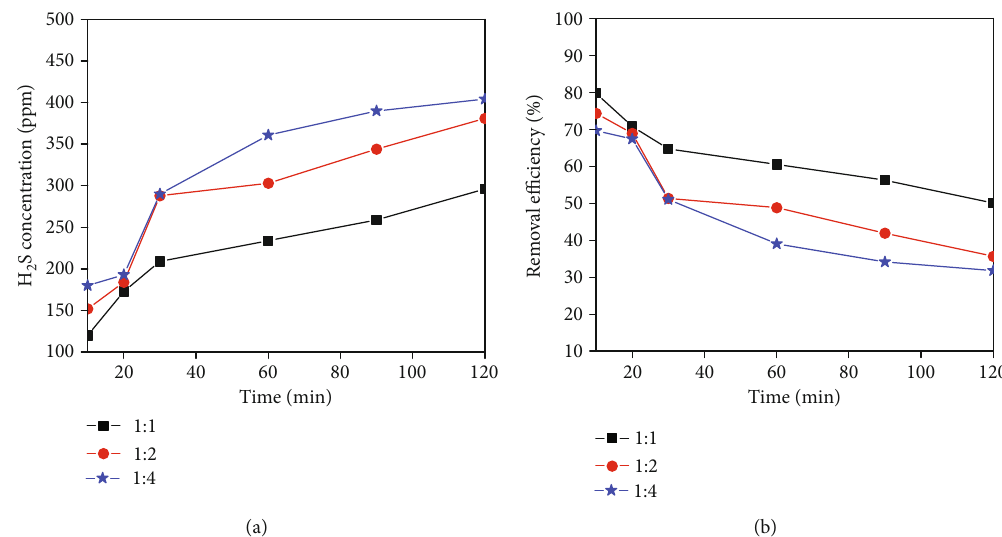
Figure 6: E ff ect of the KOH: C ratio on the samples ’ adsorption performance: (a) H = 800 ° C , m = 0 : 3g , FR = 0 : 02m 3 /h , C Test conditions: T c